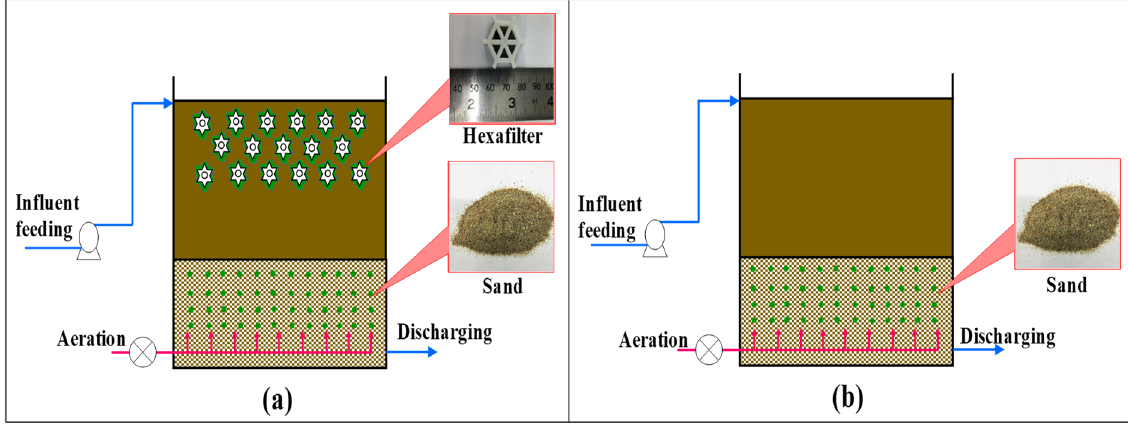
Figure 1. Schematic diagram of ( a ) DM-BR and ( b ) C-BR.